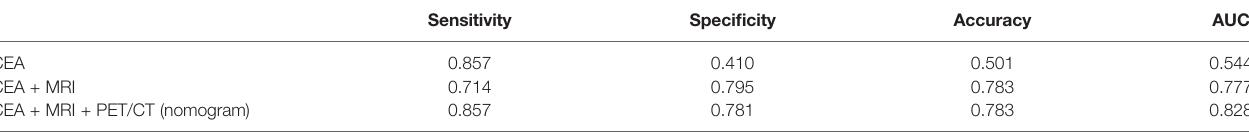
TABLE 4 | Performances of models for the validation group.